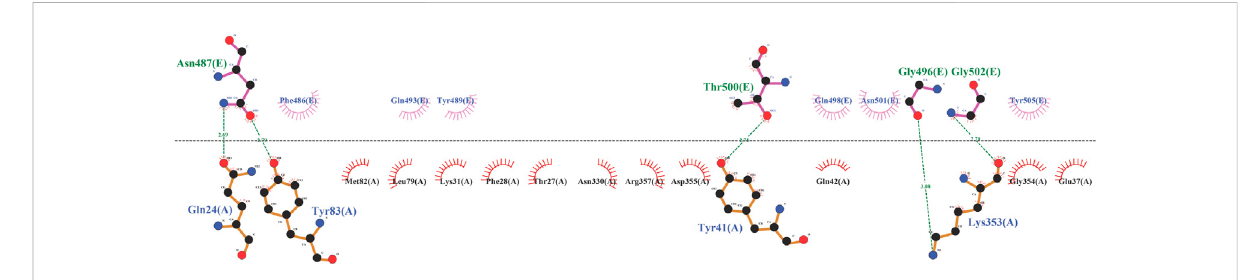
FIGURE 1 The illustration of interactions between PD (black) and template (blue).